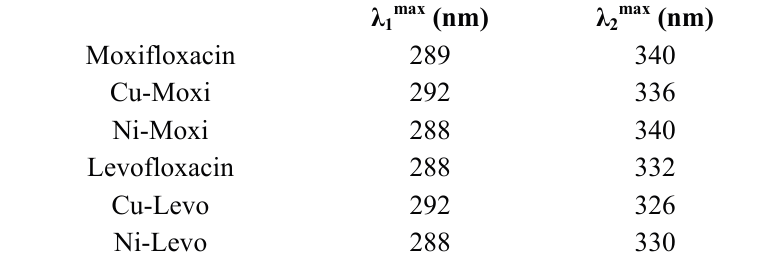
Table 1. Maximum UV absorption of fluoroquinolones and their complexes at pH =